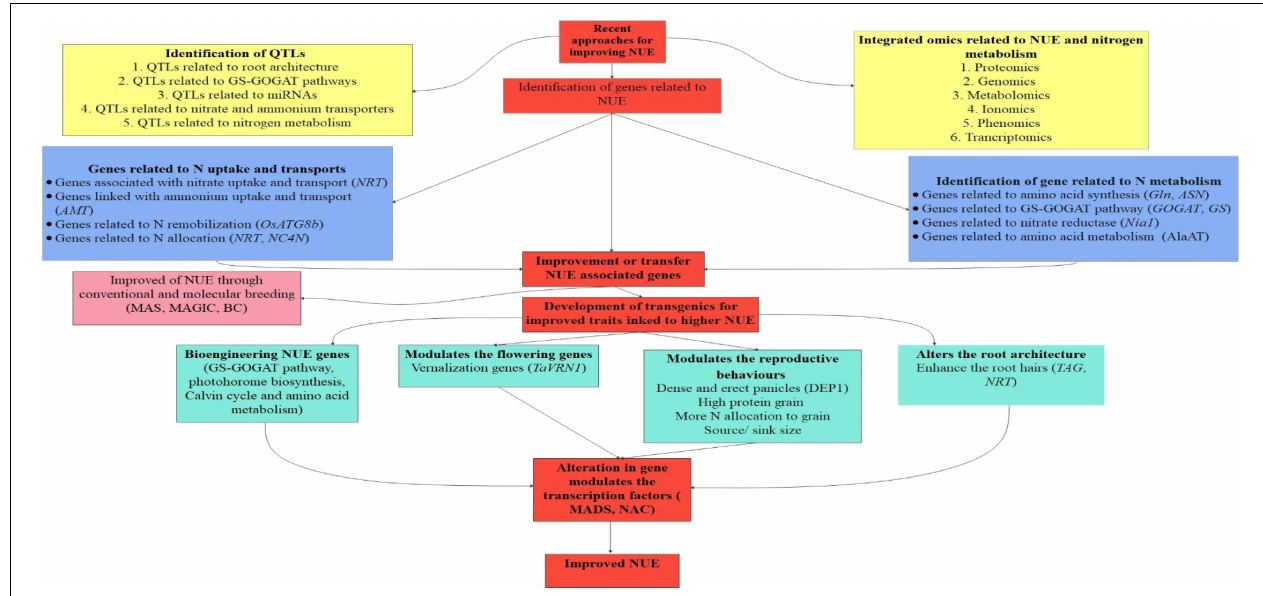
FIGURE 4 | Represents the advances in molecular biology in improving NUE. In this, the identification of QTLs (Quantitative trait loci) related to root architecture, miRNAs (micro RNA), transporters, and metabolism is crucial for improving NUE. In this sequence the application of genomics, proteomics, phenomics, and metabolomics have great opportunities to enhance NUE. Then the identification and transfer of genes related to NUE and nitrogen metabolism play a crucial role in the development of high-NUE efficient